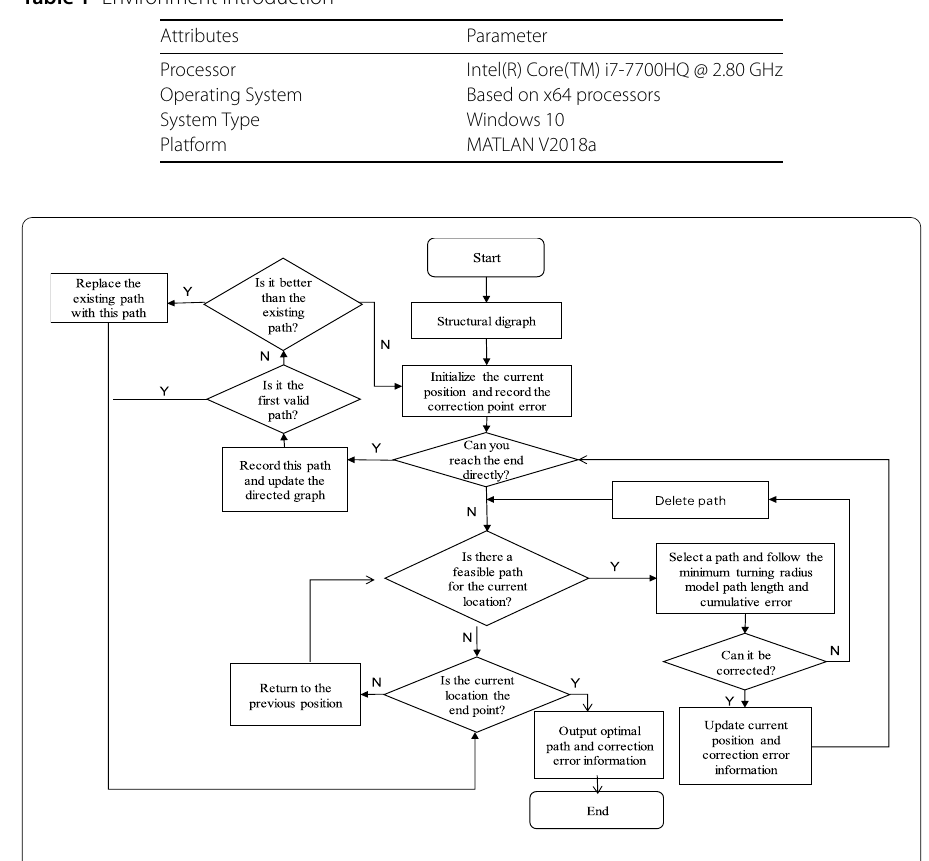
Figure 8 Algorithm flow chart of route planning